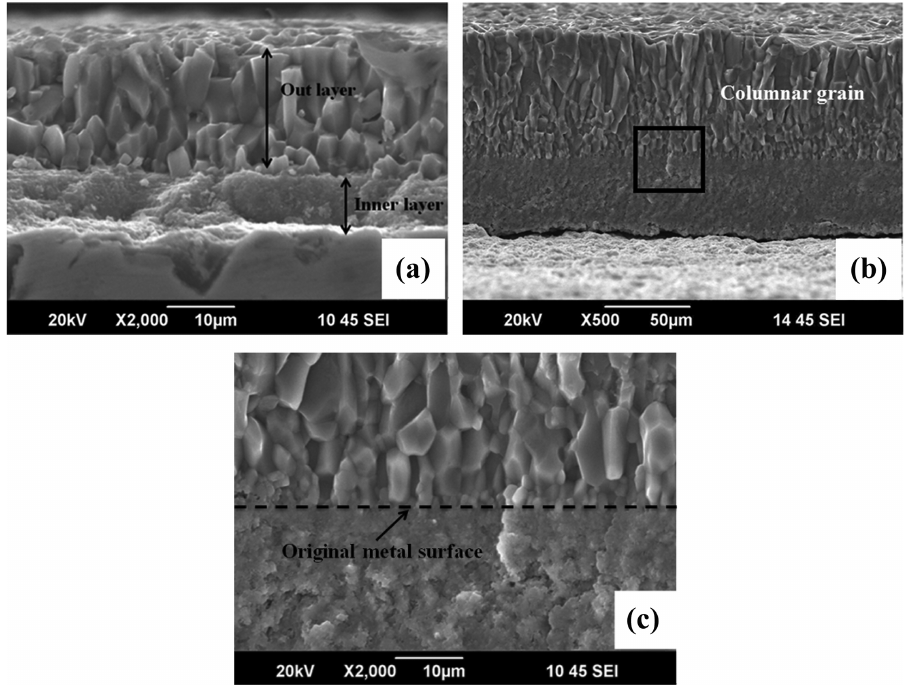
Figure 9: SEM images of the fractured cross-section of T22 sample exposed to SCW. (a) 540°C for 1000 h, (b) 620°C for 1000 h, (c) higher magnification view of region in (b) (Black